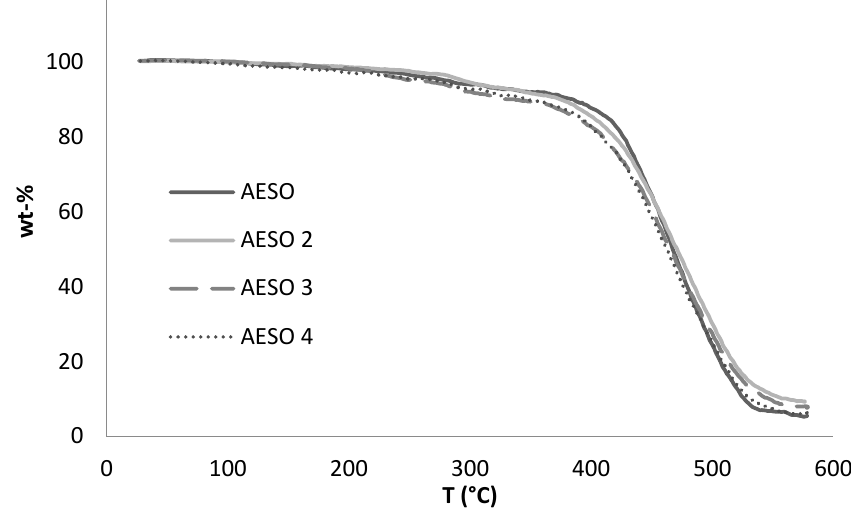
Figure 5. The thermal behaviour of pristine AESO and cellulose-reinforced AESO foams.